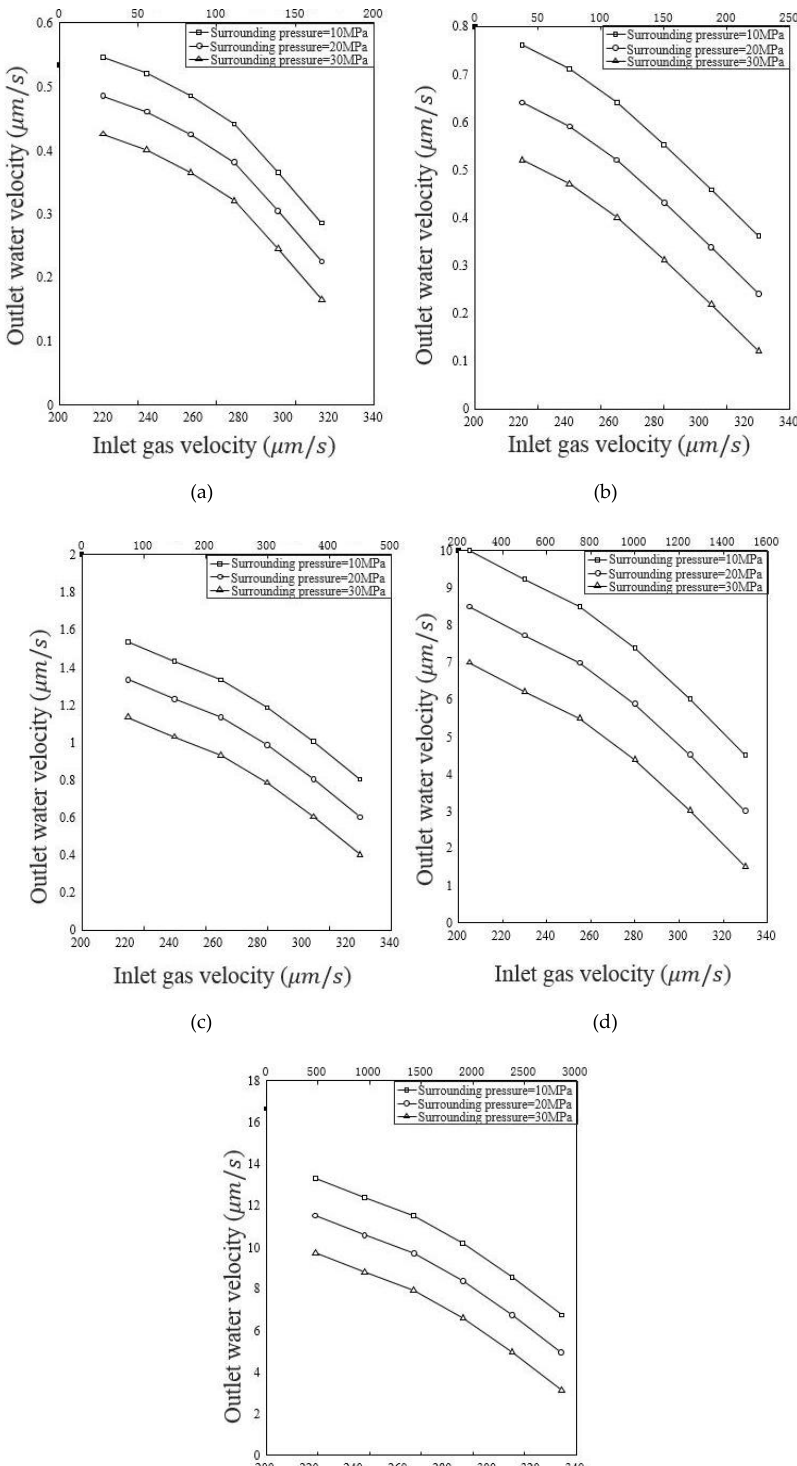
Figure 15. Outlet gas velocity with an inlet gas pressure ( p w = 200 kPa) for different samples, ( a ) Sample C1, ( b ) Sample C2, ( c ) Sample C3, ( d ) Sample C4, ( e ) Sample C5.